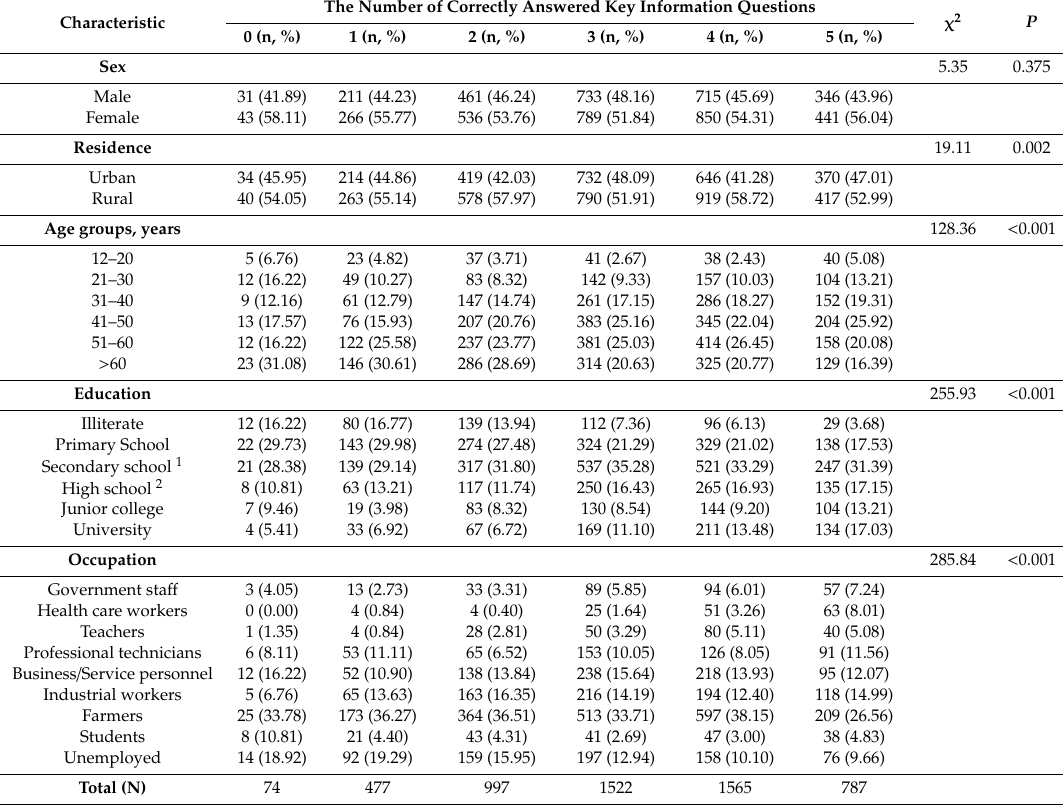
Table 4. The number of correctly answered questions on key information about TB among respondents with di ff erent characteristics in Zhejiang Province, China from October 2018 to December 2018. The Number of Correctly Answered Key Information Questions Characteristic